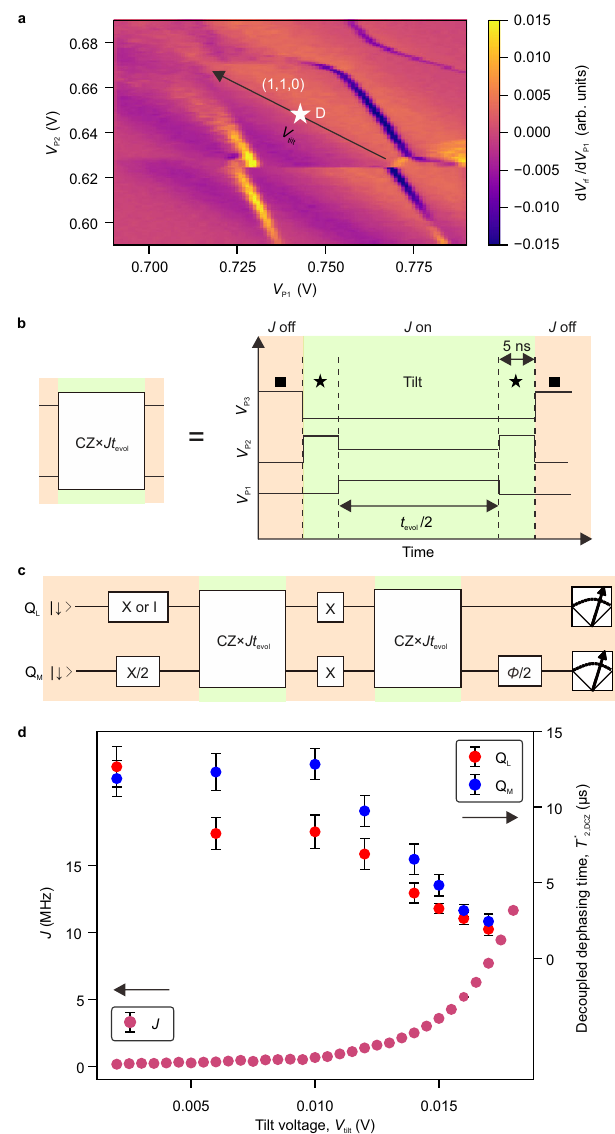
Fig. 3 | Exchange coupling switching by coherent shuttling of Q M . a Charge stability diagram around the coupled state measured as a function of the P1 and P2 gate voltage. The black arrow and the white star show the tilt voltage axis and itsorigin( V tilt =0V),respectivelyin( d ). b , c Adetailedvoltagepulsesequence( b ) and quantum circuit ( c ) used for measurement in ( d ). A wait time of 5ns at V tilt =0V(thechargesymmetry-point)isinsertedbeforeandafteratiltingvoltage pulse to avoid unintentional charge transition during switching of the exchange coupling. d Operationpoint dependence of J andthedecoupleddephasingtimes for both qubits in the coupled state. A phase of the fi nal π /2 rotation for Q M is varied to obtain the phase accumulation in Q M . By comparing the phase of Q M in two different conditions of Q L prepared in spin-down and -up, we obtain the controlled-phase2 π Jt evol asafunctionofthetotalevolutiontime t evol ,fromwhich we extract J . We fi nd that J is ∼ 0.1MHz at V tilt =0V which is limited by a small tunnel coupling t L between the left and center dots (Supplementary Note 1). This is too small to implement a CZ gate with decoupled dephasing times of ∼ 10 µ s. J canbeenhancedbyincreasing V tilt .ThedecoupleddephasingtimeofQ M is obtained from the exponential decay of the oscillation amplitude of spin- up probability as a function of the phase of the fi nal π /2 rotation for Q M (Sup- plementary Fig. 8). Single-qubit gates for Q L and Q M are swapped to measure the decoupled dephasing time of Q L . The decoupled dephasing times are longer than those obtained without decoupled sequence as shown in Supple- mentary Fig. 5b. The errors represent the estimated standard errors for the best- fi t